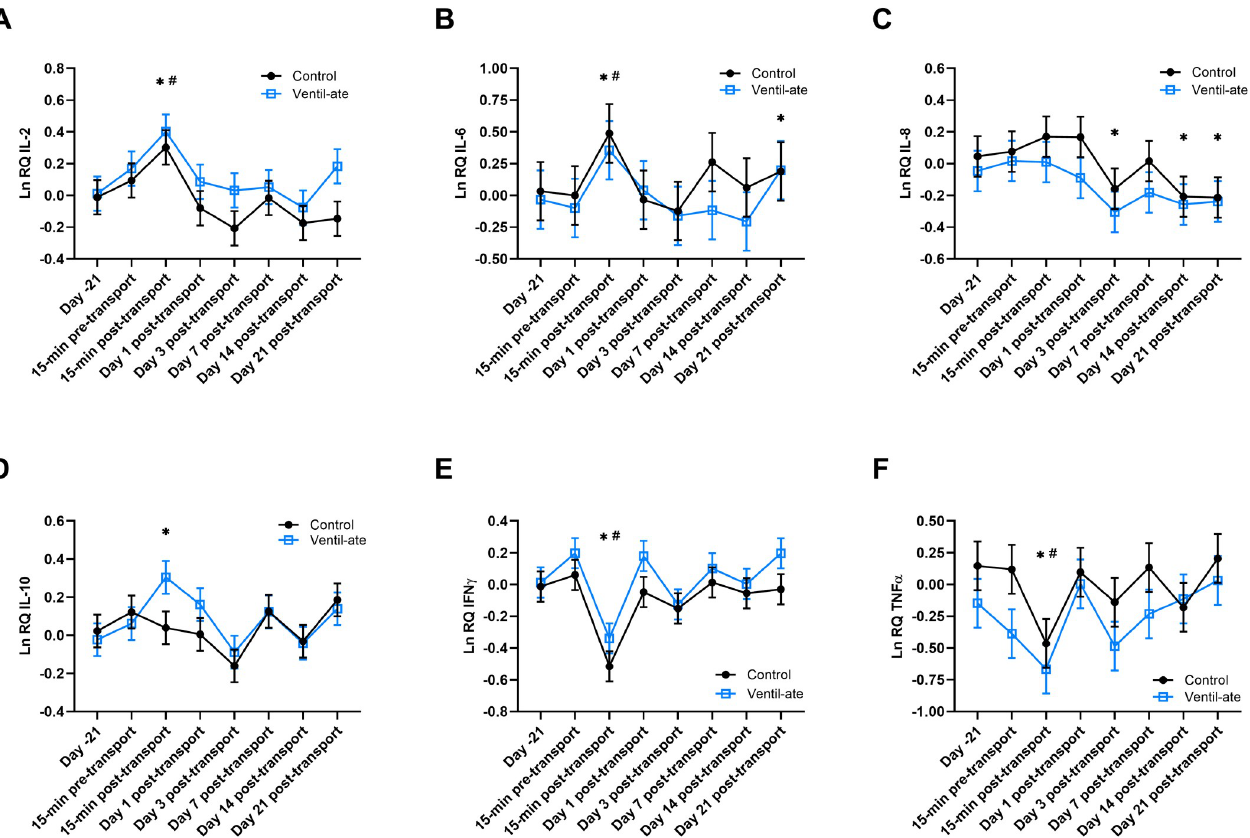
Fig 4. Whole blood gene expression of (A) IL-2 with baseline (Day –21) values included as a covariate, (B) IL-6, (C) IL-8, (D) IL-10 with baseline (Day –21) values included as a covariate, (E) IFN γ with baseline (Day –21) values included as a covariate, and (F) TNF α with baseline (Day –21) values included as a covariate. Relative quantities (RQ) are natural log (Ln) transformed. For illustrative purposes, the figure displays the results (least squares means ± SE) from the analyses that included the group-by-time interaction; however, the significant differences noted on the figures were determined from the analyses with only group and time included as main effects. (A–F) No significant group or group-by-time effects were observed, but significant time effects were detected (A, B, E: P < 0.0001 and C, D, F: P < 0.01). � denotes a significant difference ( P < 0.05) from baseline (Day –21). (A, B, E) # denotes a significant difference ( P < 0.05) from all other time points. (F) # denotes a significant difference ( P < 0.05) from all other time points except Day 3 post-transport. IFN γ , interferon gamma; IL, interleukin; TNF α , tumor necrosis factor